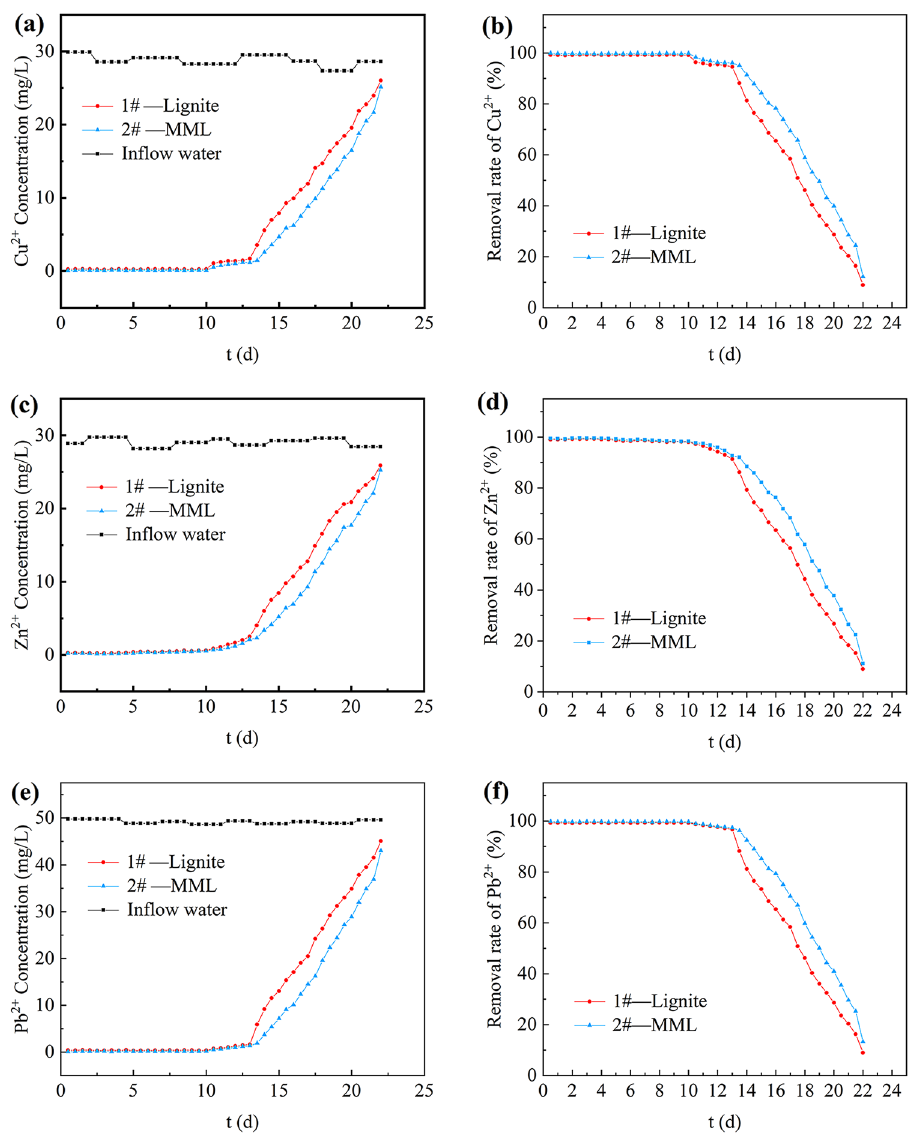
Figure 7. Removal effect of heavy metal ion. ( a ) Cu 2+ concentration of effluent; ( b ) removal rate of Cu 2+ ; ( c